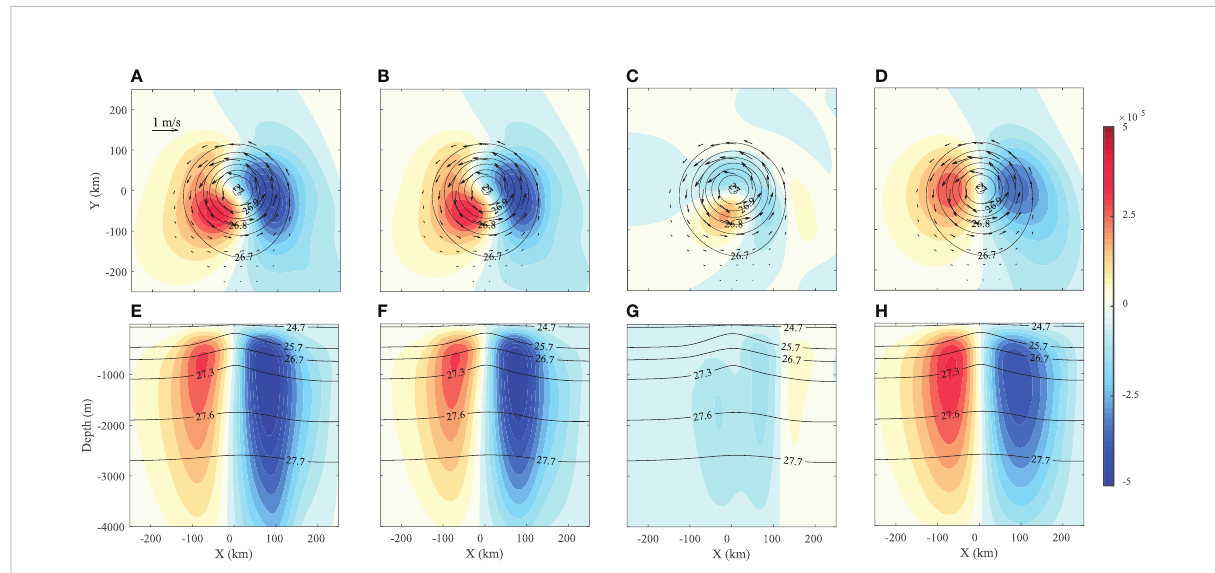
FIGURE 5 Time-mean depth-averaged (0~2000 m) w in the idealized eddy on the b -plane (upper row) obtained from the (A) ROMS outputs, (B) w - equation with all terms, (C) w -equation without the b -term, and (D) w -equation with the b -term only (shading), superimposed by the time mean r (contours) and horizontal velocity (vectors) on the surface, and corresponding vertical pro fi les of w across the eddy centers in the zonal direction lower row, (E – H) , superimposed by the time mean r